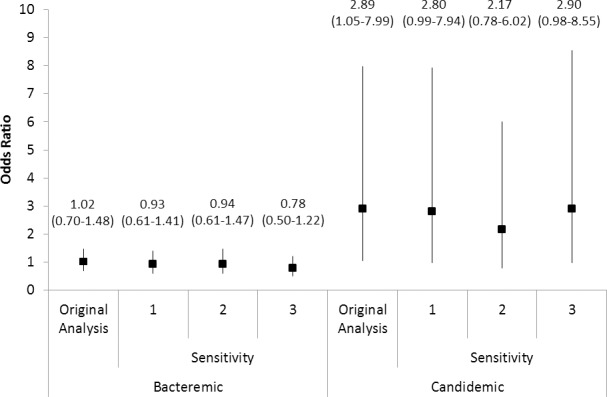
Adjusted odds ratios with 95% confidence intervals showing the effect of inadequate treatment on patient mortality, stratified by bacteremia versus candidemia, and under three different sensitivity analyses [1: excluding patients with early deaths (n = 1,042), 2: defining treatment inadequacy using a 2-day rather than a 1-day window (n = 1,161), 3: excluding patients who received no antimicrobial treatment (n = 1,081)].